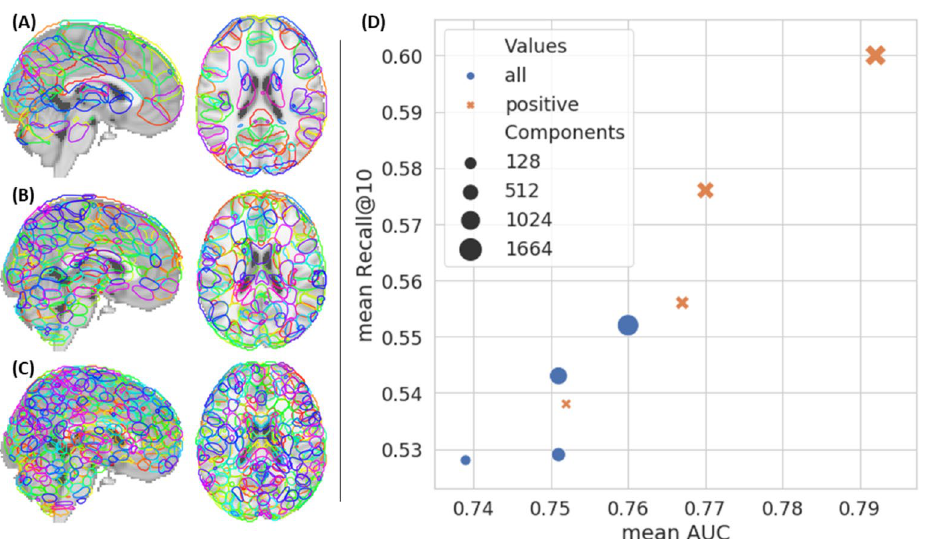
Figure 2. Preliminary identification of suitable image representations for large-scale decoding. ( a ), ( b ) and ( c ) respectively illustrate the components of the 128, 512 and 1024-components dictionaries. In each dictionary, the components are sparse but they have some overlap. In ( d ) we compare both the decoding performance for 37 concepts extracted from the original annotation, from projections on each dictionary as well as from the stacking of all projections, either for all values or just the positive